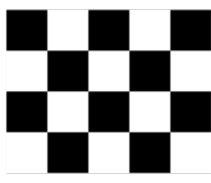
Figure 3. Visual marker used for oscillation